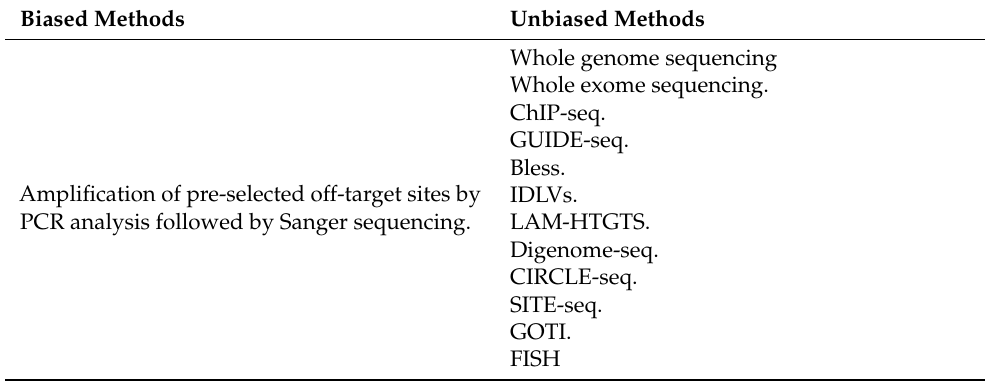
Table 2. Methods for off-target detection (for further details see [76,77]). Biased